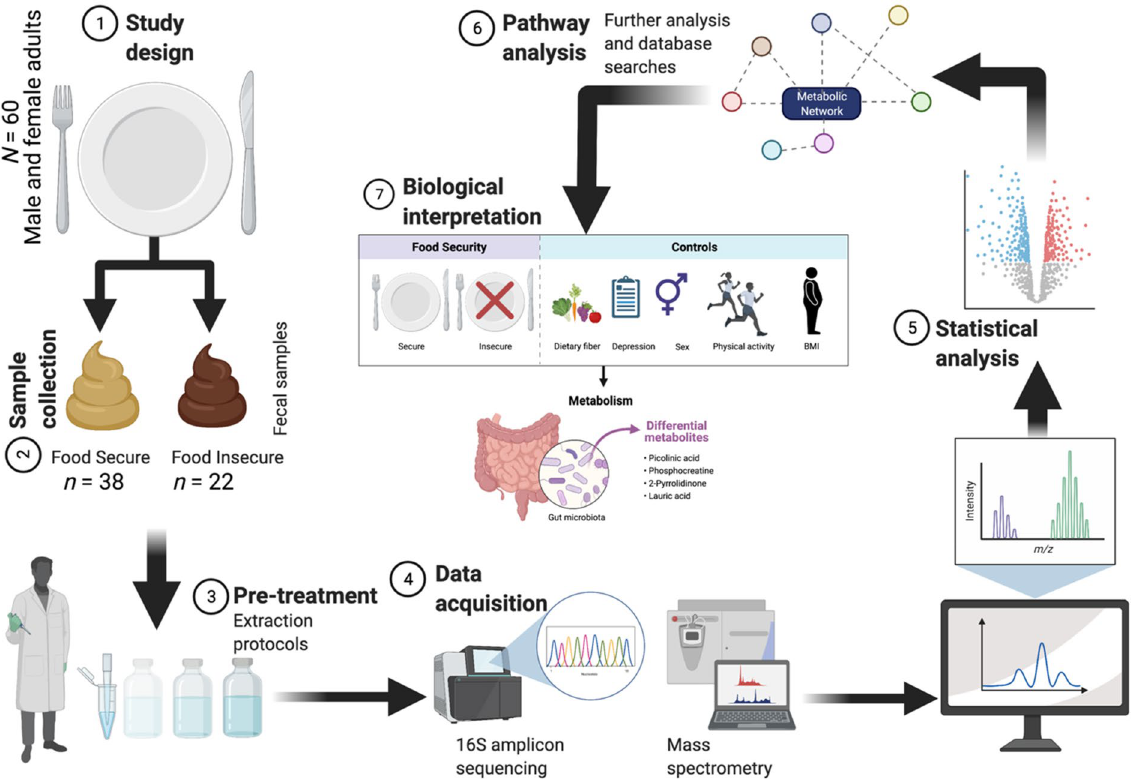
Figure 1. Overview of analytical workflow: male ( n = 20) and female ( n = 40) college students (mean age = 18.5 ± 0.7 years) were recruited and classified by food security status within the last 30 days. Fecal samples were collected and microbiome and metabolomic analyses were performed via 16S amplicon sequencing and mass spectrometry, respectively. Following data integration and metagenome assembly, statistical and predictive analyses were performed to articulate molecular signatures associated with recent food security. Created with